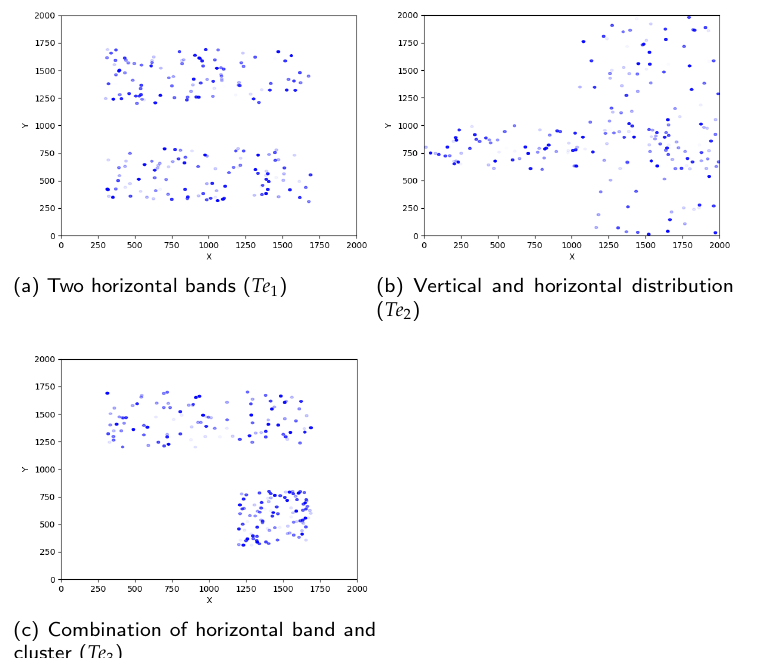
Figure 2. The figures show three testing scenarios ( T e 1 , T e 2 , and T e 3 ). The robustness of the best- evolved solution will be tested in these